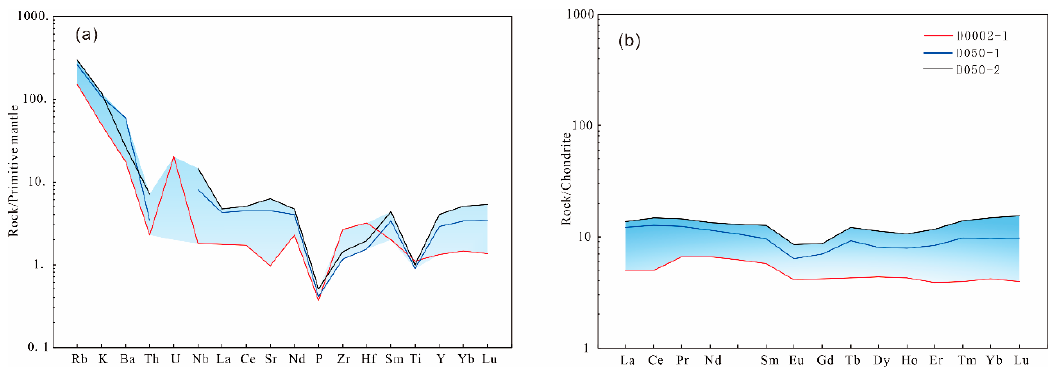
Figure 14. ( a ) Primitive-mantle-normalized trace element distributions and ( b ) chondrite-normalized rare earth element patterns for the biotite–tremolite schist enclaves from the Kongling Terrane. Normalizing values are from Sun and McDonough (1989) [30].